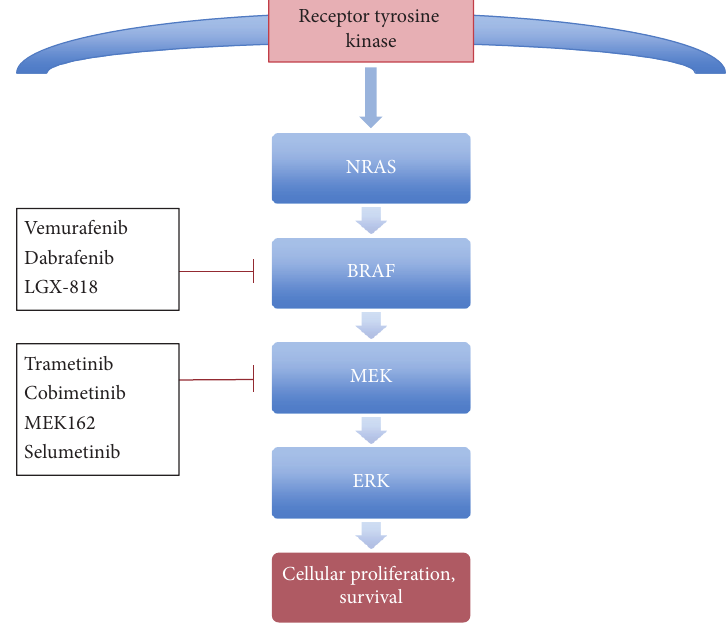
Figure 1: The MAPK signalling pathway and drugs currently in